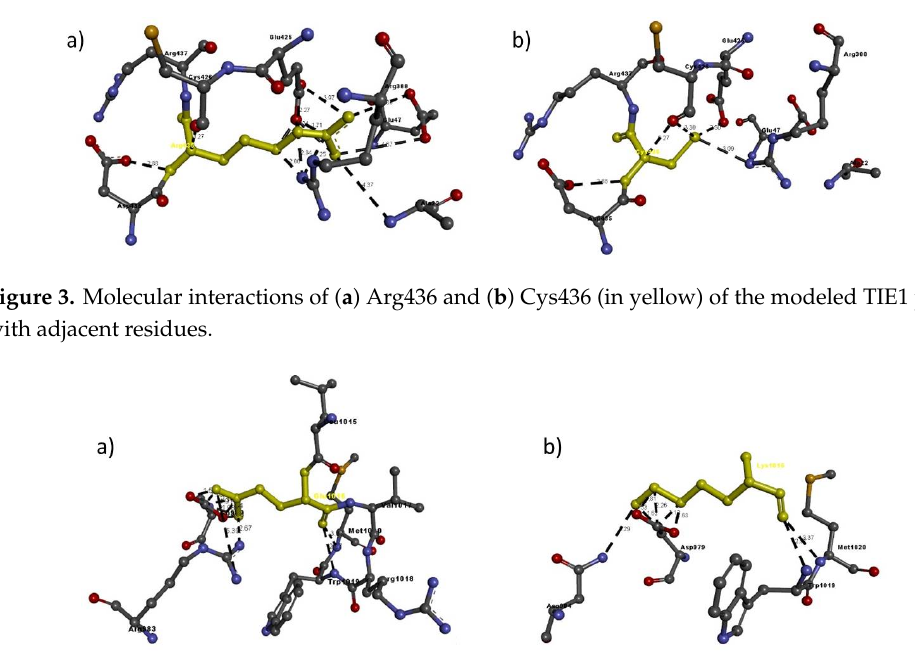
Figure 4. Molecular interactions of ( a ) Glu1016 and ( b ) Lys1016 (in yellow) of the modeled TIE1 protein with adjacent residues.